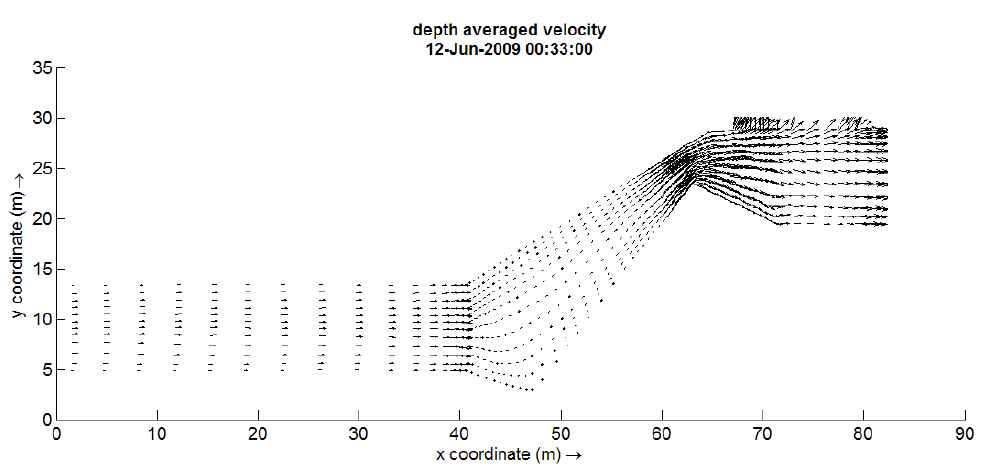
Figure 13. Velocity vector variation in the flow system for HDS scenario.